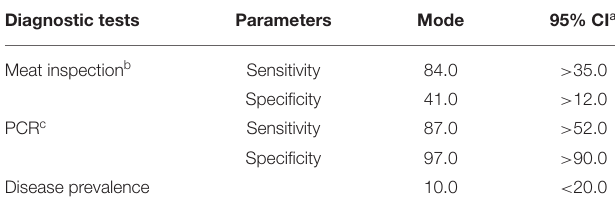
TABLE 1 | Prior estimates for mode and 95% confidence interval (CI) for sensitivity and specificity values of meat inspection and polymerase chain reaction (PCR) test and prevalence of the disease